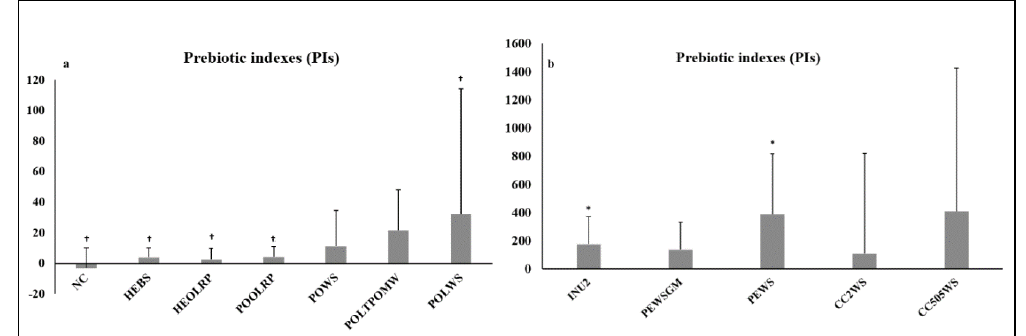
Figure 1. Prebiotic Indexes (PIs) of the tested mushrooms and controls after 24-h fermentation ( a : NC, HEBS, HEOLRP, POOLRP, POWS, POLTPOMW and POLWS treatments; b : INU2, PEWSGM, PEWS, CC2WS and CC505WS treatments);Values are expressed as mean and SD (for POLTPOMW and